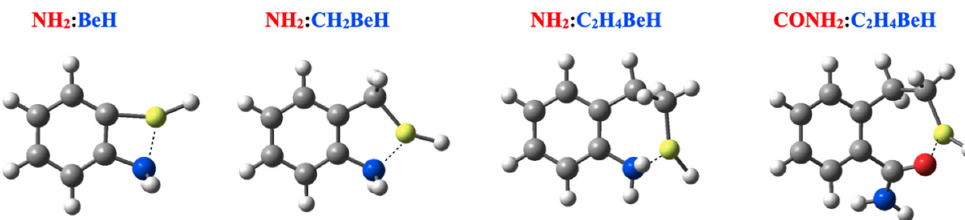
Figure 2. Suitable examples of the global minima where the formation of the intramolecular beryllium bond leads to the formation of an extra four-(NH 2 :BeH), five-(NH 2 :CH 2 BeH), six-(NH 2 :C 2 H 4 BeH) or seven-(CONH 2 :C 2 H 4 BeH) membered heterocycle. The atoms color code is the same as in Figure 1.